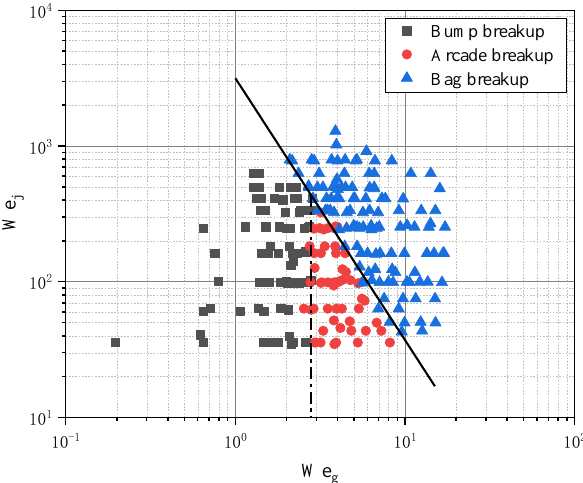
Figure 9. Primary breakup regime map of a liquid jet in a low–speed air crossflow based on We g and We j .